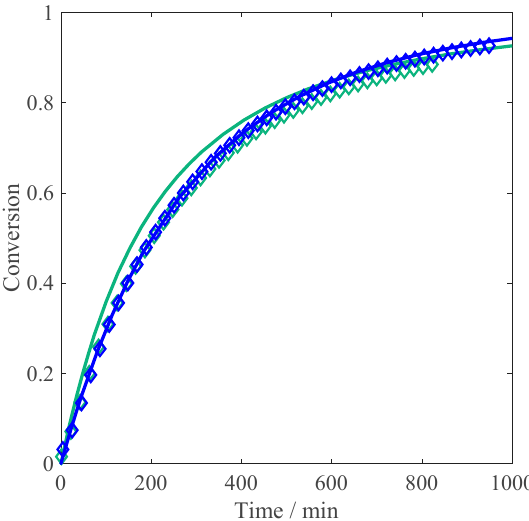
Figure 8. Propagation rate coefficient as a function of the monomer conversion calculated from the termination rate coefficient in Table 5 and the experimental data of conversion versus time of fully ionized MAA polymerization at constant ionic strength equivalent to 10 wt % MAA by addition of NaCl. Variation of monomer concentration 1 wt % (red), 5 wt % (green), and 10 wt % (blue, no NaCl addition): comparison with the simulated k p using the model equations (lines).